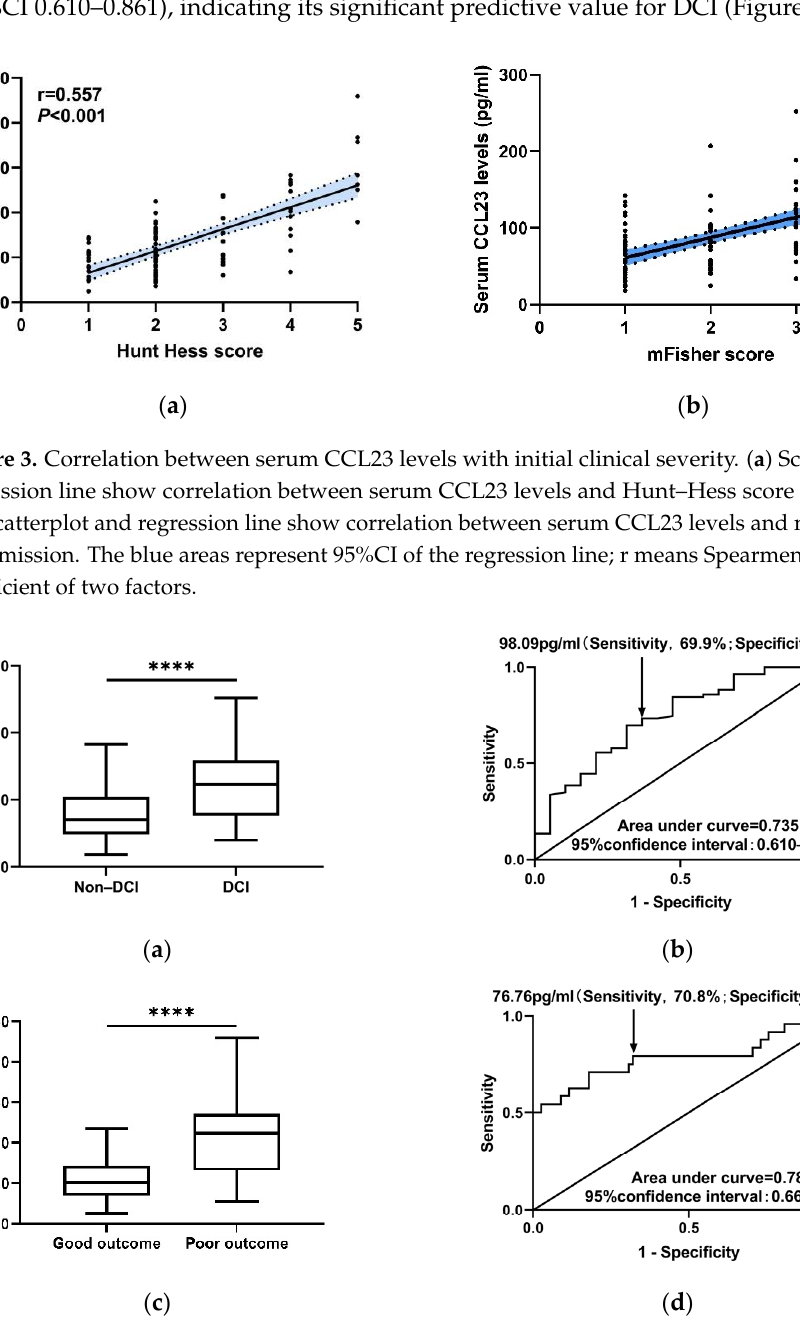
Figure 4. Serum CCL23 levels predict 6-month outcome of aSAH patients. ( a ) Boxplot shows serum CCL23 levels in patients with or without DCI. ( b ) ROC curve shows the discriminatory ability of serum CCL23 levels to predict DCI in aSAH patients. ( c ) Boxplot shows serum CCL23 levels in patients with or without DCI. ( d ) ROC curve shows the discriminatory ability of serum CCL23 levels to predict 6-month poor outcome in aSAH patients. Boxplots represent Turkey boxplots, and points outside the whiskers are outliers. Arrows represent the optimal cutoff value determined using the Youden index. **** p <